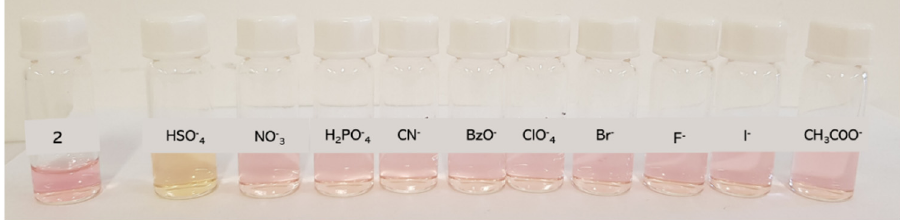
Figure 2. Color change observed for BODIPY derivative 2 in acetonitrile/water (75:25) upon addition of 50 equivalents of several anions.